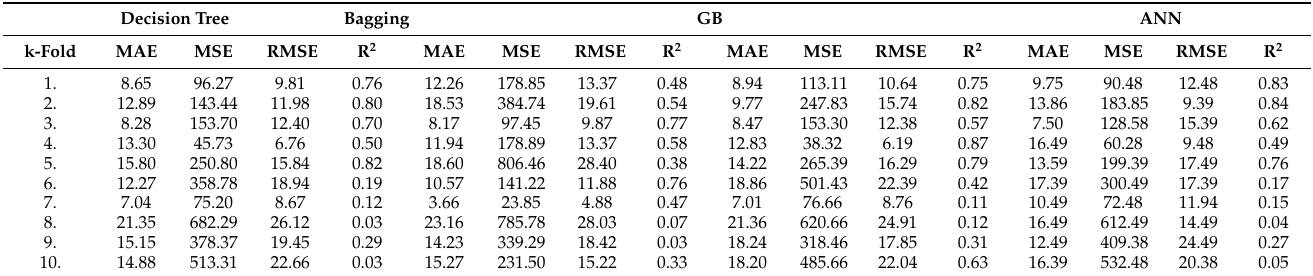
Figure 4. Statistical indication of the k-fold cross validation. DT ( a ); bagging ( b ); GB ( c ); ANN ( d ). Table 3. Analysis of the k-fold